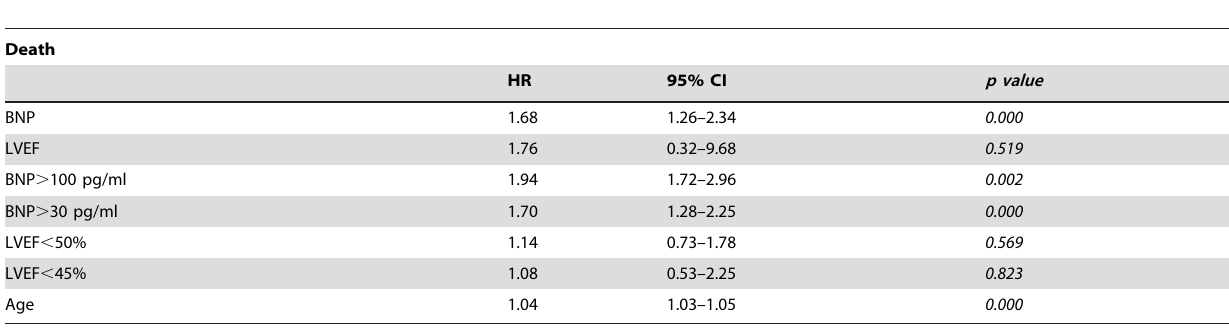
Table 5. Univariate Cox regression analysis for predicting overall death in relation to selected cut-off values of BNP concentration and